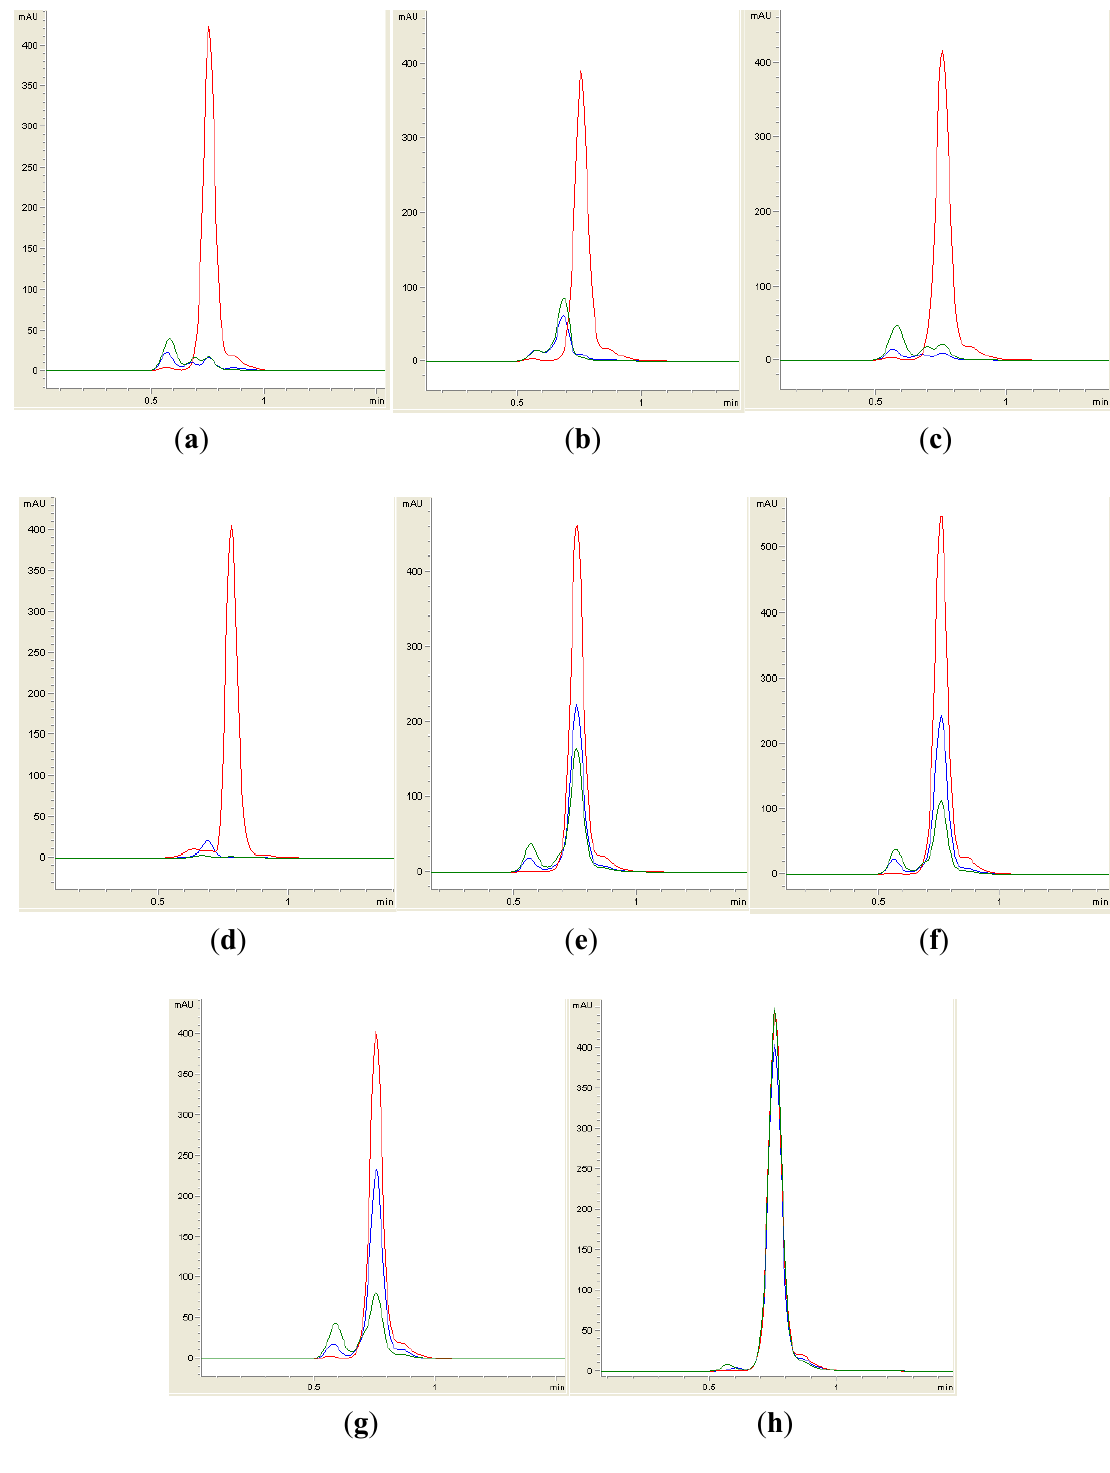
Figure 4. RRLC analysis of pC-HSL degradation. Residual pC-HSL (with elution time of 0.75 ± 0.01 min), after degradation for 0 h (red), 12 h (blue) and 24 h (green), was monitored at 306 nm. Degradation of pC-HSL was depicted by the reduction of milli-absorbance unit (mAU) in the chromatogram. Samples containing BT1 ( a ), BT2 ( b ), BT4 ( c ), BT6 ( d ), BT8 ( e ), BT9 ( f ) and B. cereus ( g ) showed degradation of pC-HSL. E. coli TOP10 ( h ) was used as the negative